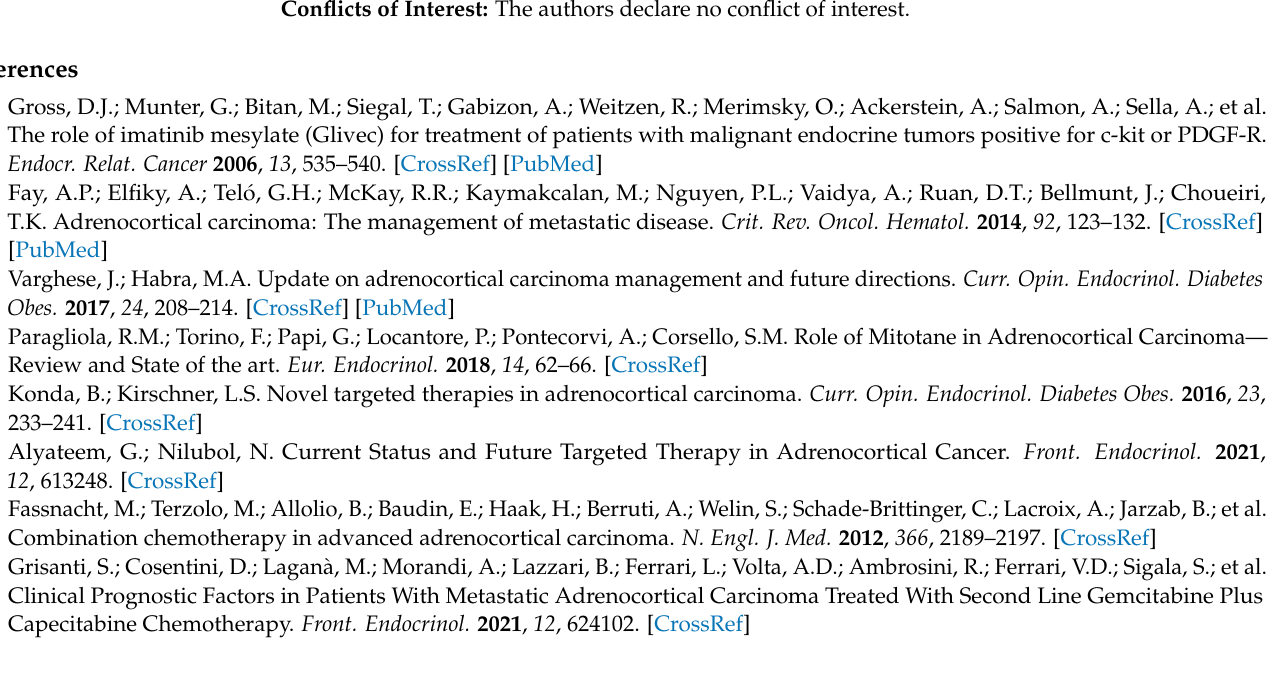
Table S2: List of drugs in clinical trials; Table S3: Results of genetic alterations in target genes of targeted therapy drugs in ACC; Table S4: Results of subgroups ACC with and without distant metastases; Table S5: Potential genetic therapy options of targeted therapy drugs in ACC; Table S6: Results of CNV-Amplification gene pair and mutation hotspots in